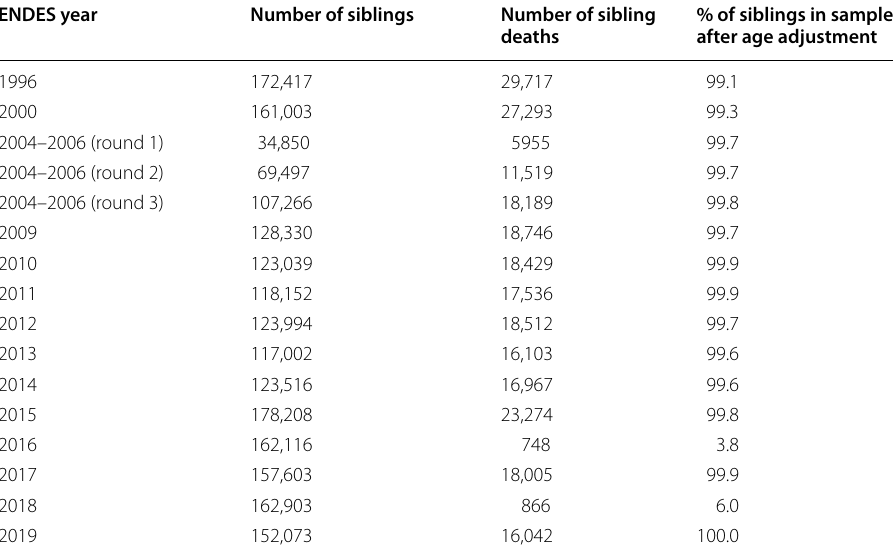
Table 5 Number of siblings and sibling deaths recorded in ENDES survey